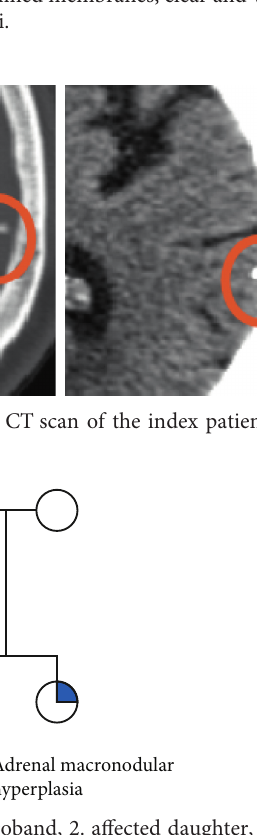
Figure 2: (H&E, original magnification x2.5)-Histologically, there is evidence of adrenal cortex thickening, with architectural dis- organization and multinodular appearance.